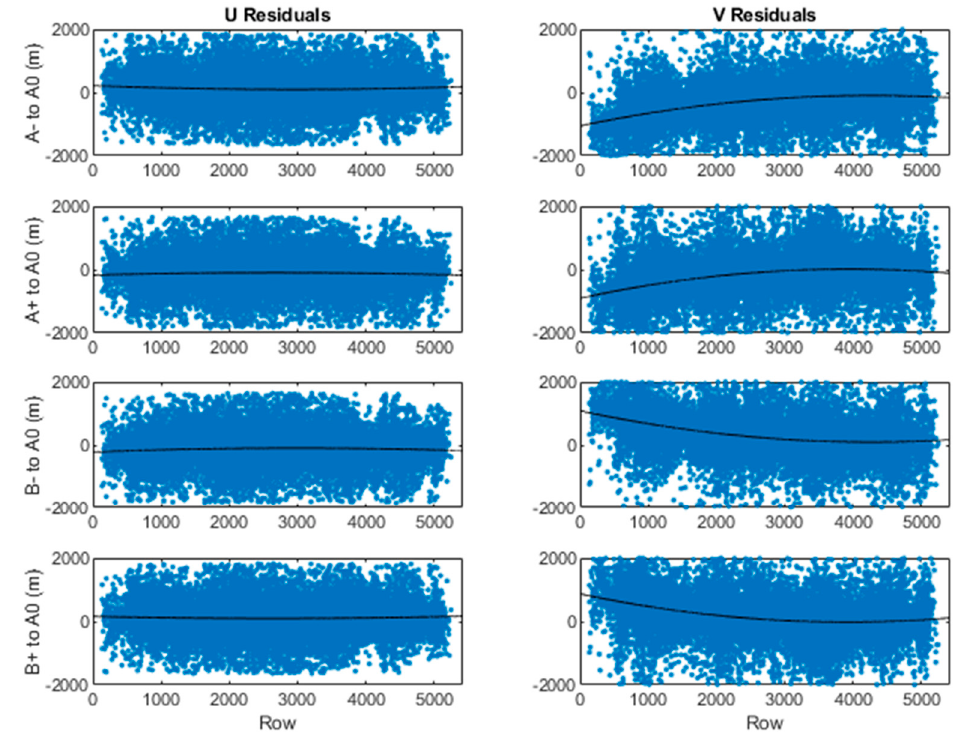
Figure 4. Residuals for an ABI-AHI FD pair show the signature of a small of systematic error in the Band 14 imagery for Himawari in relation to that of GOES-17. Least-squares second-degree fits are overplotted. For context, an IR resolution element is 2 km at SSP.